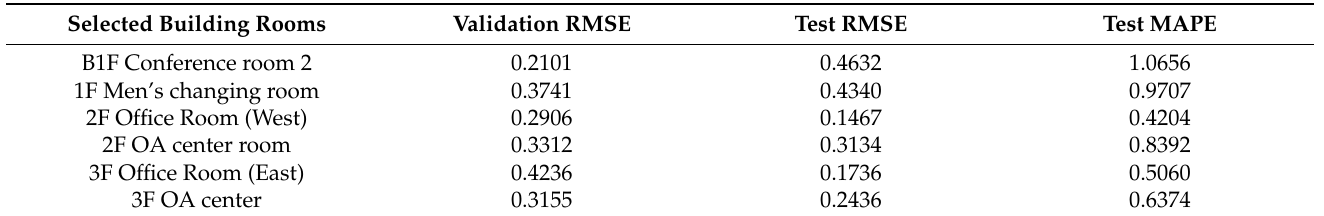
Table 2. Performance metrics for selected rooms on the validation and test temperature